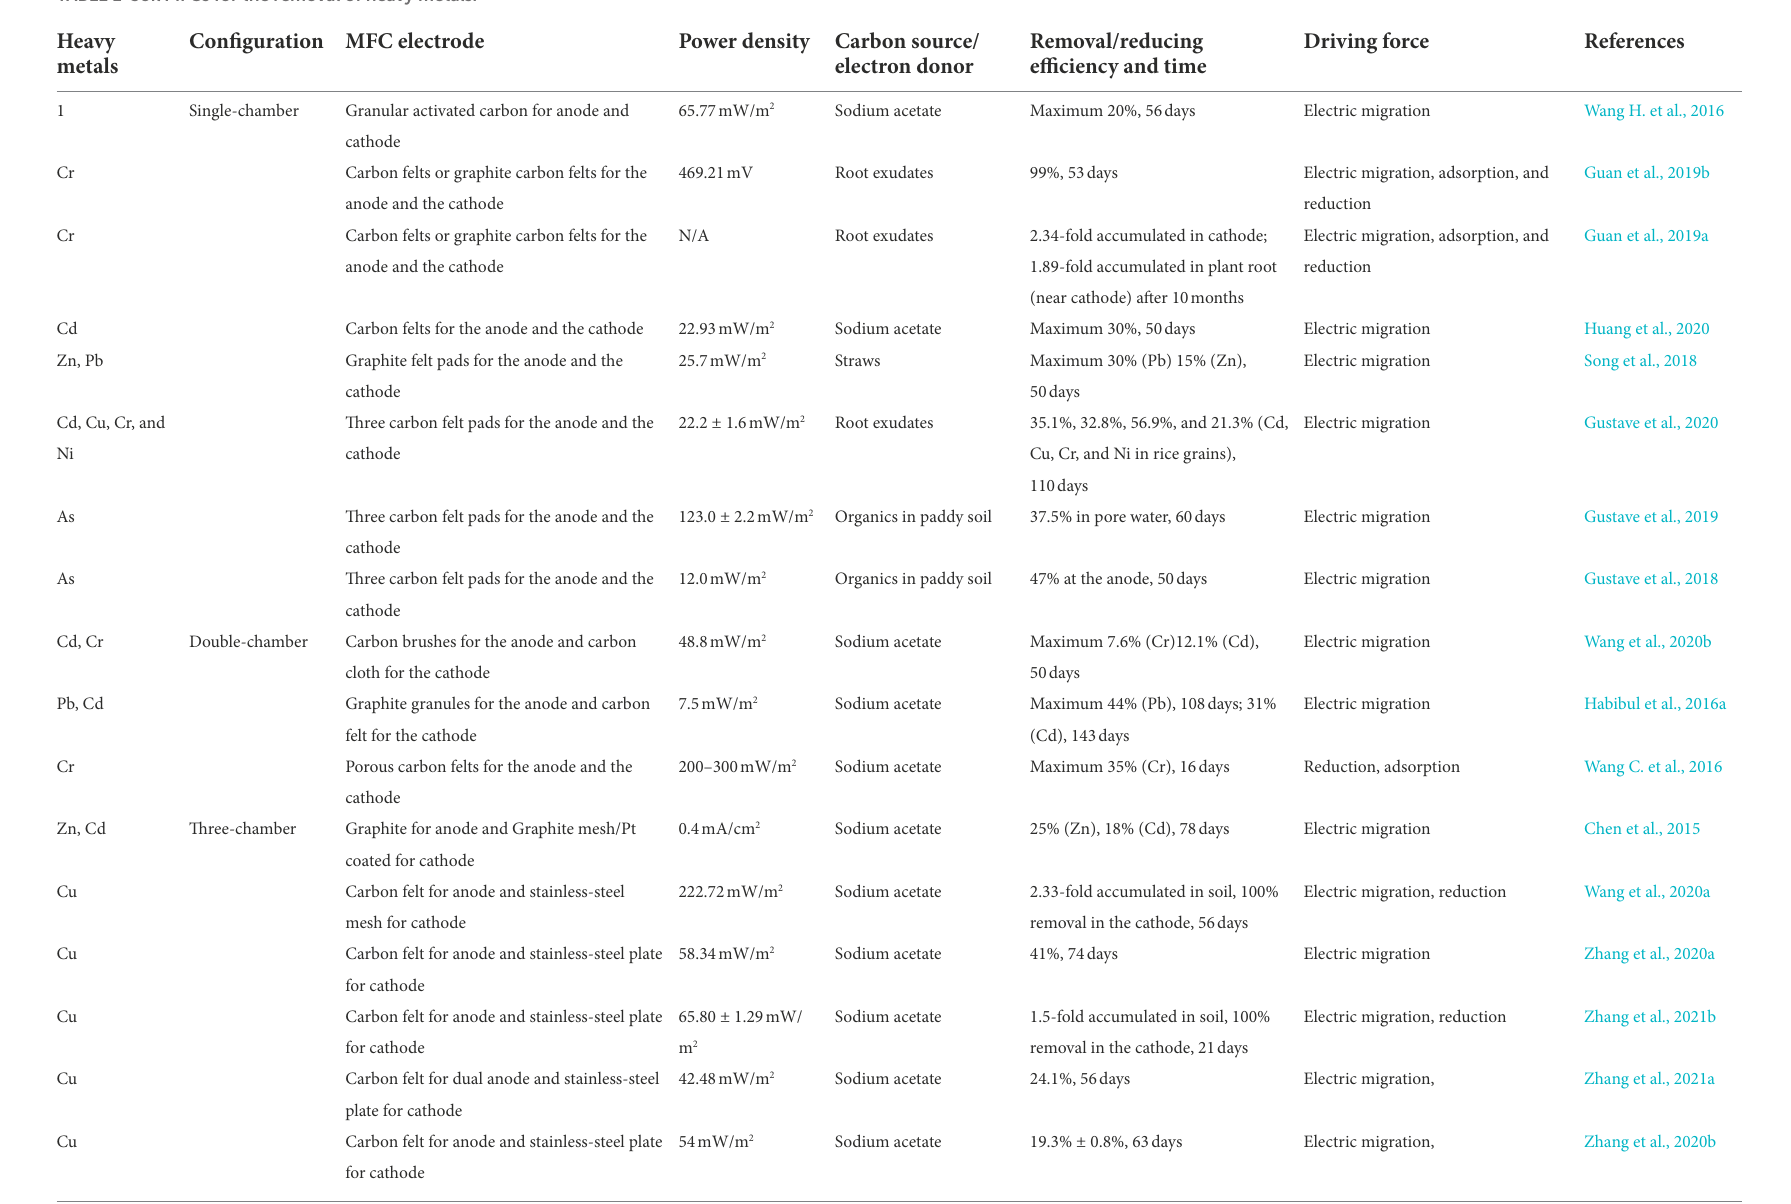
TABLE 1 Soil MFCs for the removal of heavy